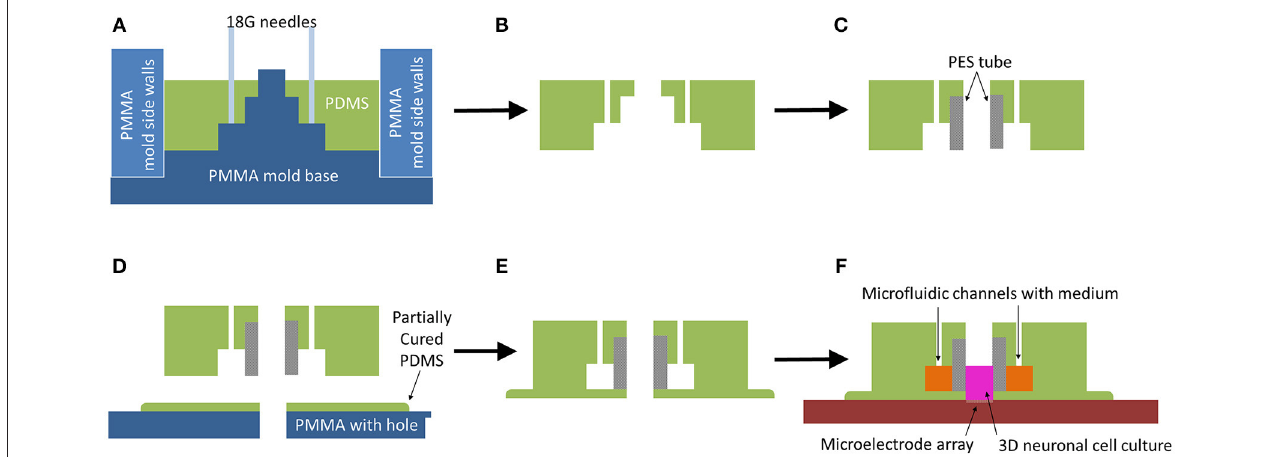
FIGURE 1 | Microbioreactor mold fabrication process. (A) Schematic view of PDMS soft lithography in assembled mold. (B) After curing the PDMS in an oven at 65 ◦ C for 4h, the PDMS is removed from the mold. (C) A porous PES cylinder is press-fitted into the opening of the PDMS, creating a membrane between the outer microfluidic channels and the central chamber for cell culture. (D) The PDMS-PES assembly is placed into a partially cured PDMS layer, obtained by curing PDMS on a PMMA plate for 17min on a hotplate at 65 ◦ C, with the hole of the central chamber and the hole in the partially cured PDMS aligned by means of a pipette tip placed through the hole in the PMMA to guide the central chamber onto the partially cured PDMS. Afterwards, it is placed back onto the hot plate to fully cure at 65 ◦ C for 2h. (E) The sealed and fully assembled microbioreactor is gently peeled off the PMMA plate. (F) The microbioreactor is placed onto a glass surface or MEA, allowing for 3D neuronal cell culture on the